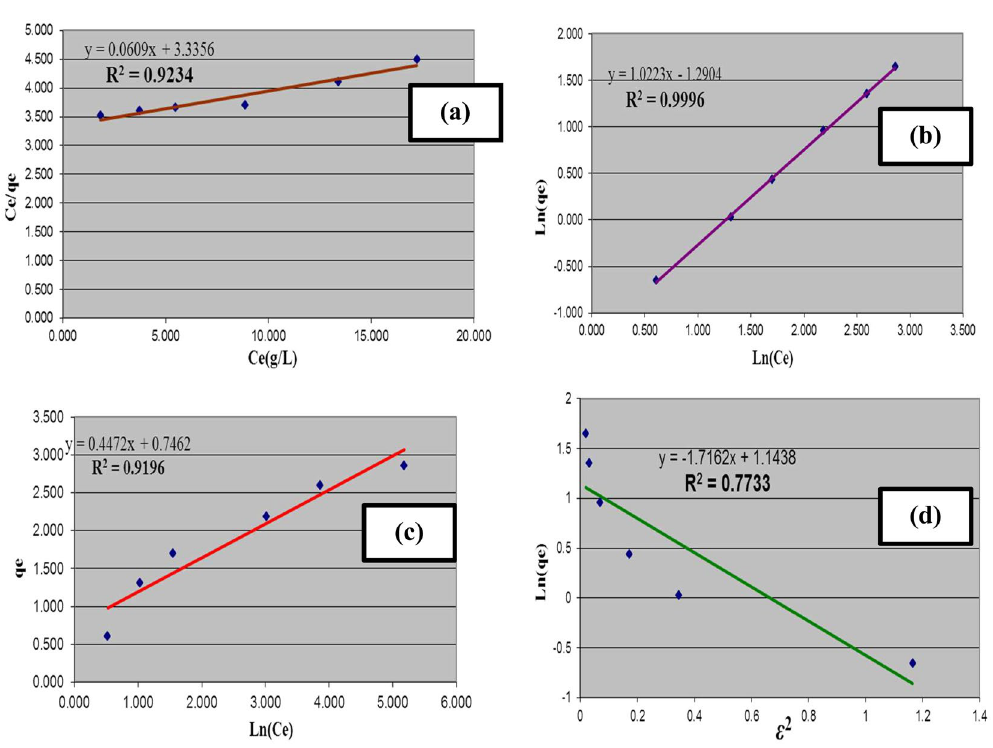
Figure 8. Equilibrium modeling of oil sorption process onto nano-magnetic activated carbon material: ( a ) Langmuir isotherm, ( b ) Freundlich isotherm, ( c ) Temkin isotherm, ( d ) Dubinin-Radushkevich